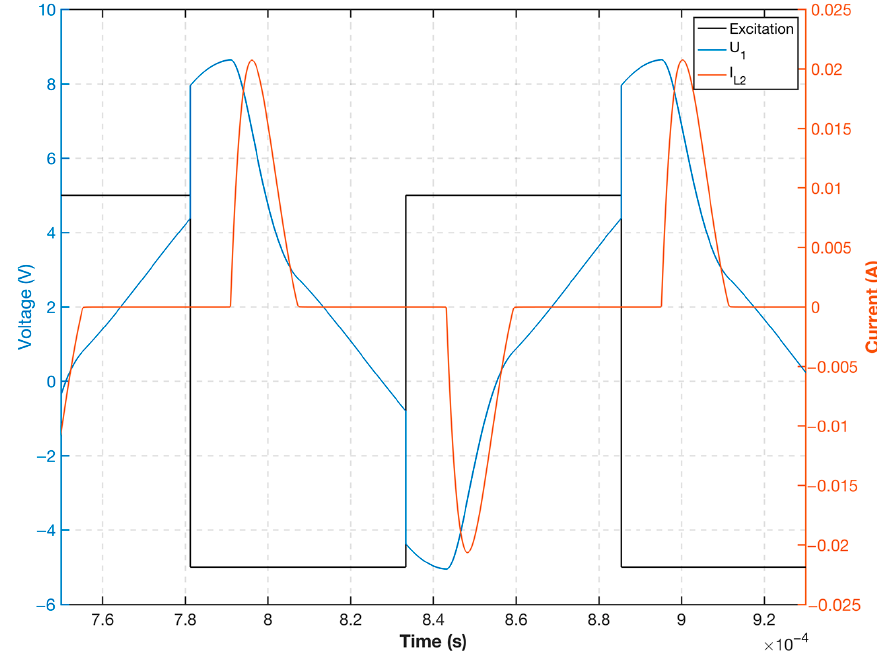
Figure 9. Excitation circuit simulation voltage and current waveforms.